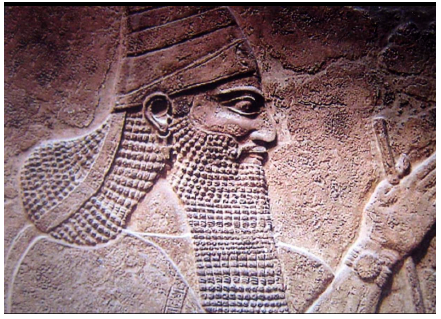
Figure 4. Curled hair and beard of an Assyrian nobleman.